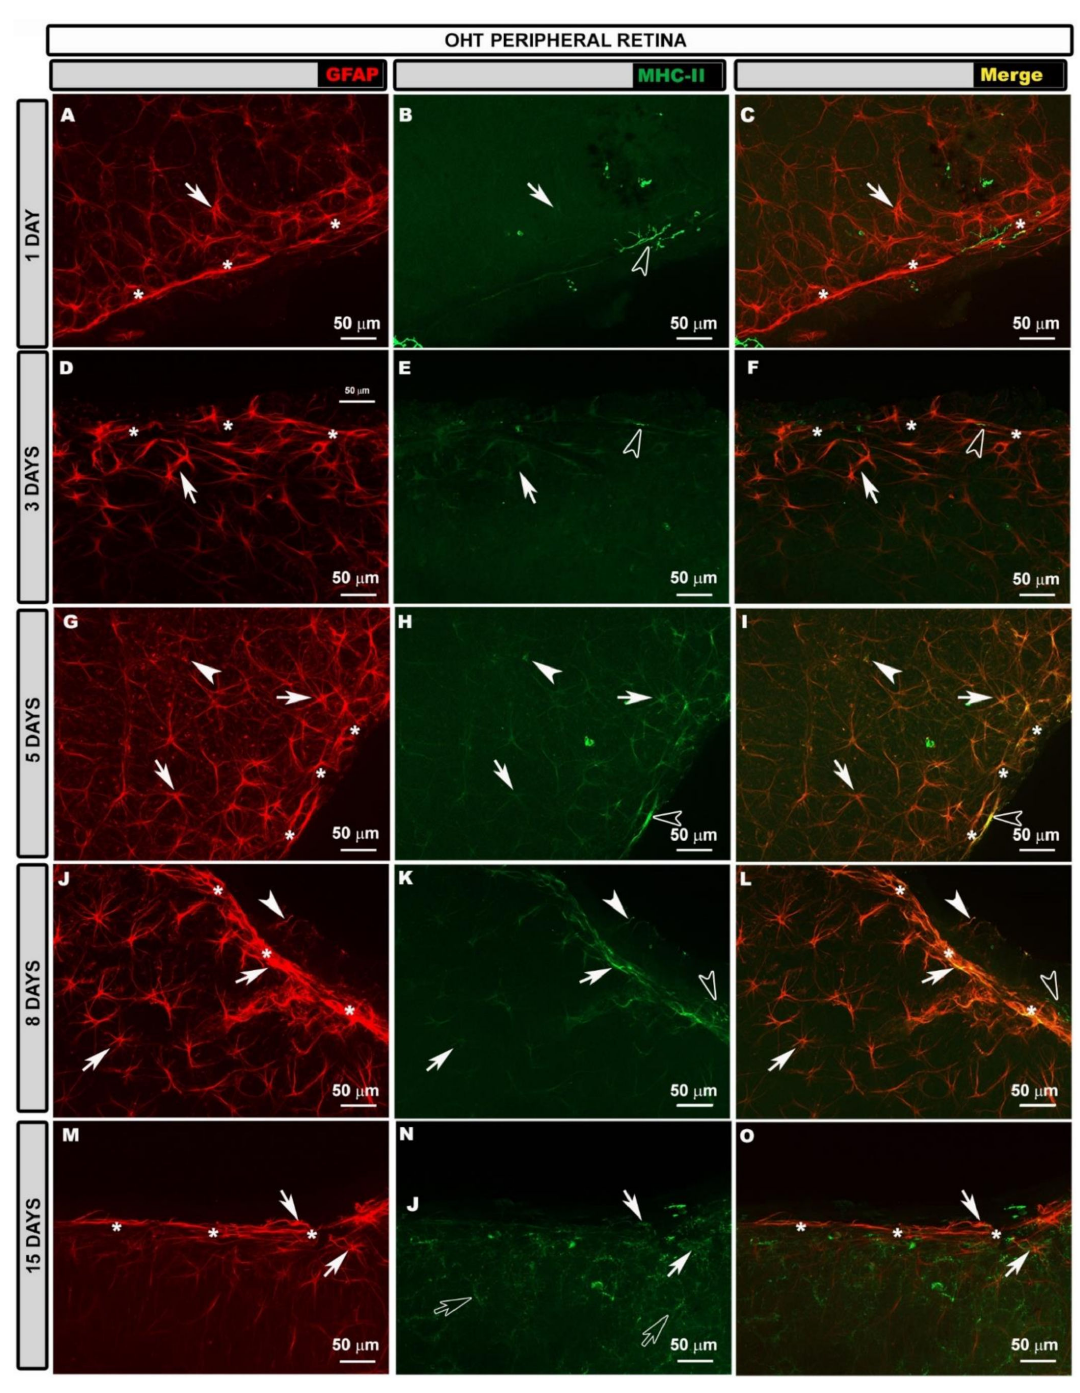
Figure 7. Retinal whole-mount. Double immunostaining for GFAP (red) and MHC-II (green) at different time points after OHT induction in OHT eyes in the peripheral retina. GFAP-labeled astrocytes are shown at different time points ( A , D , G , J , M ). In the peripheral retina, the expression of MHC-II by astrocytes (arrow) was more intense than in the intermediate retina at all time points (1 ( B , C ); 3 ( E , F ); 5 ( H , I ); 8 ( K , L ); and 15 ( N , O ) days), being comparable to that of dendritic cells (hollow arrowhead). At 15 days, microglial cells (hollow arrow) expressed MHC-II. The arrowhead points to the terminal feet of Müller glia. Asterisks mark circular peripheral blood vessel. GFAP: glial fibrillary acidic protein; MHC-II: major histocompatibility complex class II; OHT: ocular